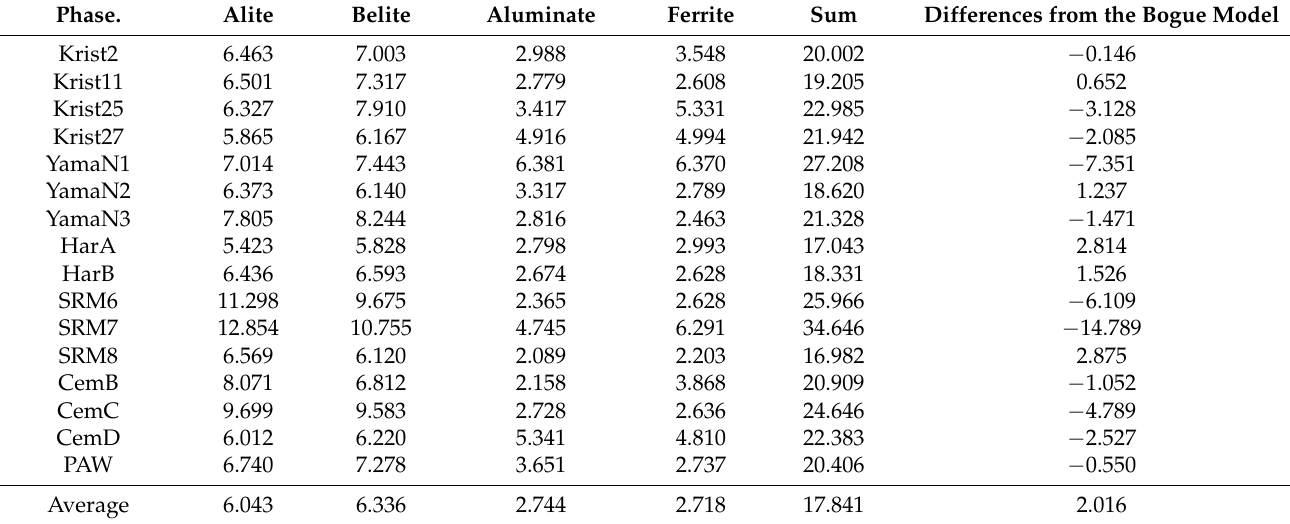
Table 11. Average absolute differences between experimental data and the results of the 17 model sets given in Appendix B.